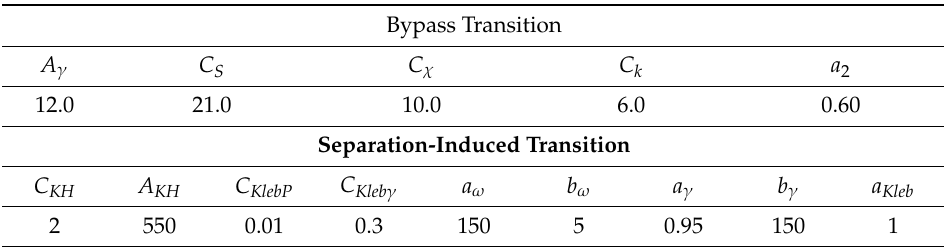
Table 1. Transition model